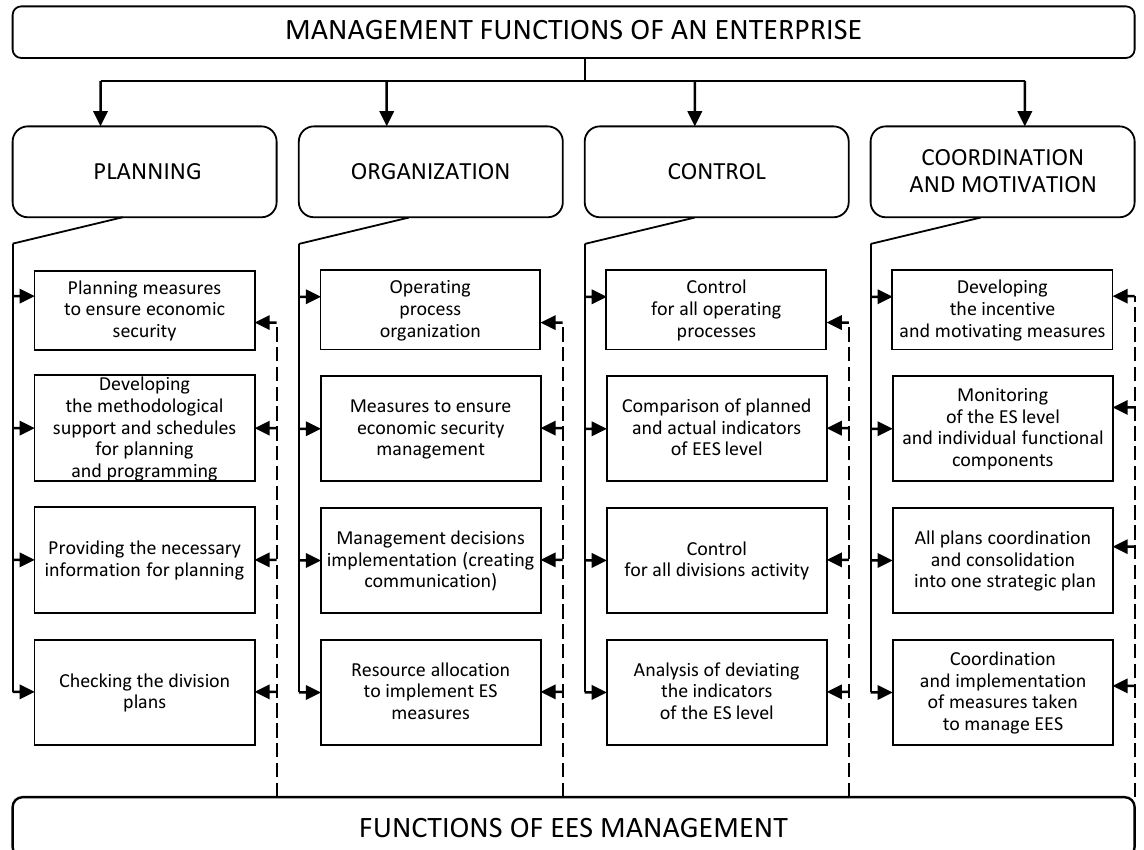
Figure 1. Relationship between the functions of economic security